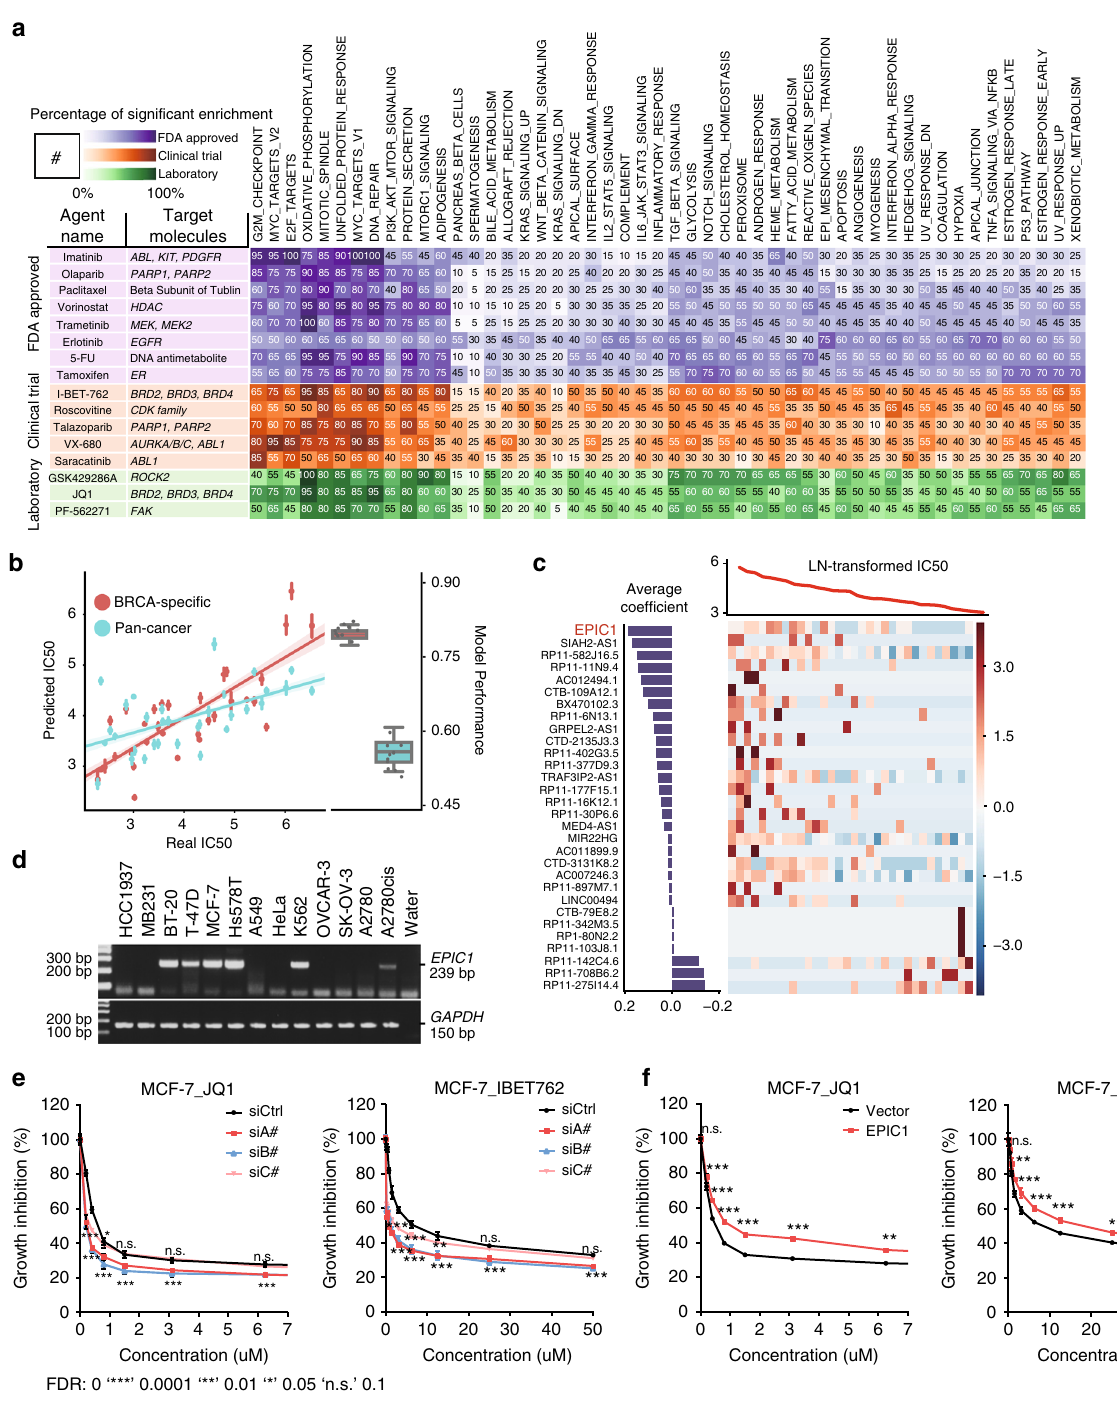
Fig. 6 EPIC1 overexpression enhances breast cancer cell lines resistance to BET inhibitors. a Enrichment of top predictive lncRNAs for each agent in cancer hallmark pathways. The left panel lists the target information of the agents. The right panel shows the number of predictive lncRNAs that are signi fi cantly associated with cancer hallmarks (FDR < 0.25 by GSEA). b Comparison of LENP model predicted IC50 in ten iterations and observed IC50 for I-BET-762. Model performance in ten iterations for both pan-cancer and BRCA-speci fi c models were demonstrated in the box plot. center lines represent median performance, the box limit indicates the lower quantile and upper quantile, and whiskers represent the poorest and best performance. Data are presented as mean ± SE ( n = 10 for 10 iterations of CV). c LENP model for I-BET-762 in BRCA. The top curve shows observed IC50 of I-BET-762 in each cell line. The central heatmap shows the top predictive lncRNA expression in the model across all cell lines ( x -axis). Bar plot (left): weight of the top predictive lncRNAs in the model for I-BET-762 sensitivity (bottom) or insensitivity (top). d Endogenous expression level of EPIC1 in 13 cell lines and water. e Growth inhibition curves for EPIC1 knockdown or control MCF-7 cells treated with BET inhibitor I-BET-762 (left) and JQ-1 (right). f Growth inhibition curves for EPIC1 overexpression or control MCF-7 cells treated with BET inhibitor I-BET-762 (left) and JQ-1 (right). Data are presented as mean ± SD ( n = 3 for technical